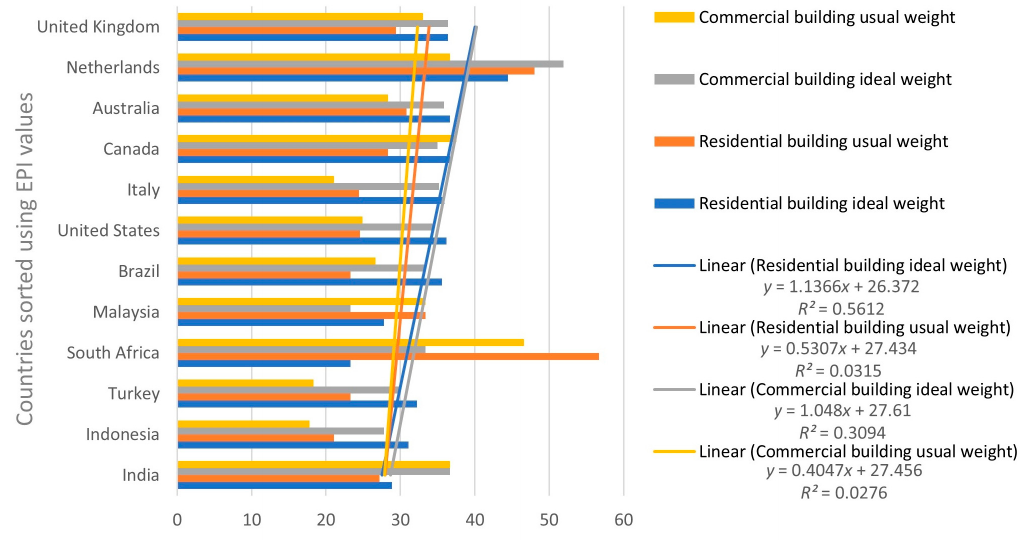
Figure 5. Environmental sustainability weights for different countries sorted by EPI score.